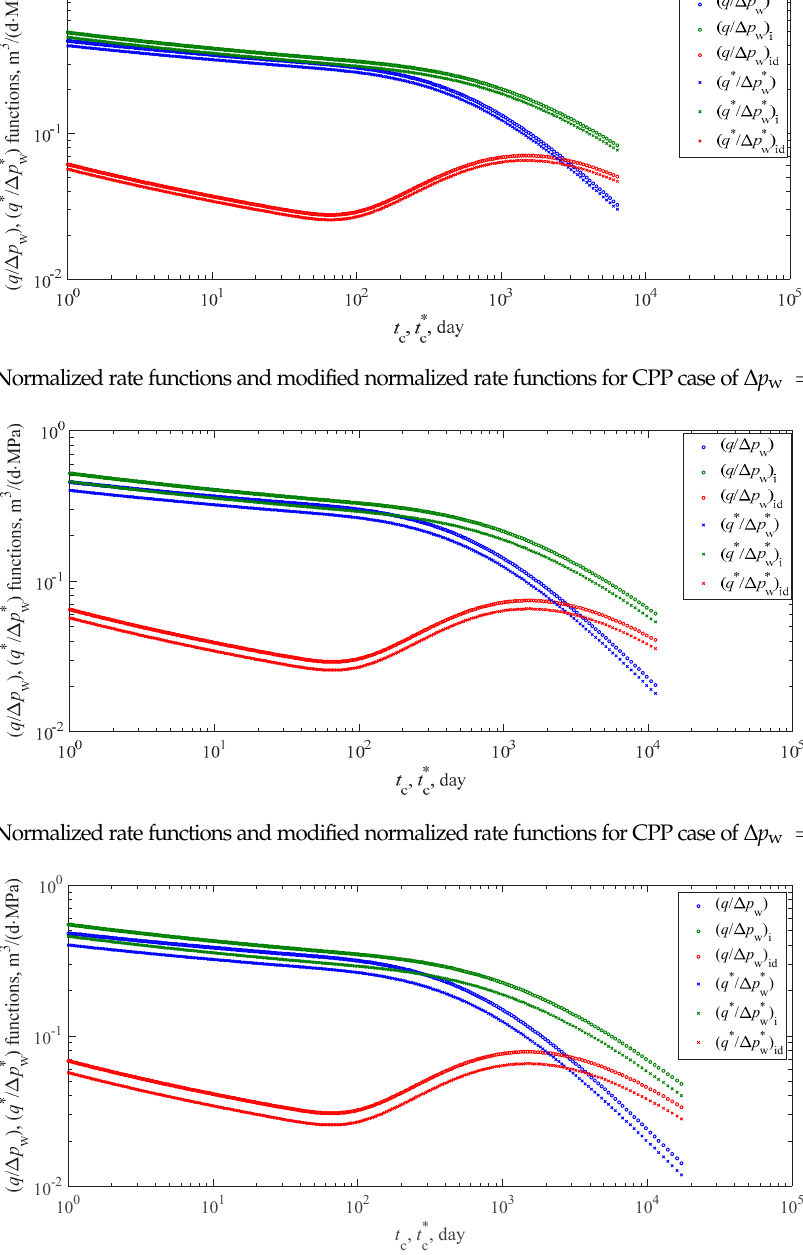
Figure 7. Normalized rate functions and modified normalized rate functions for CPP case of ∆ p w = 70